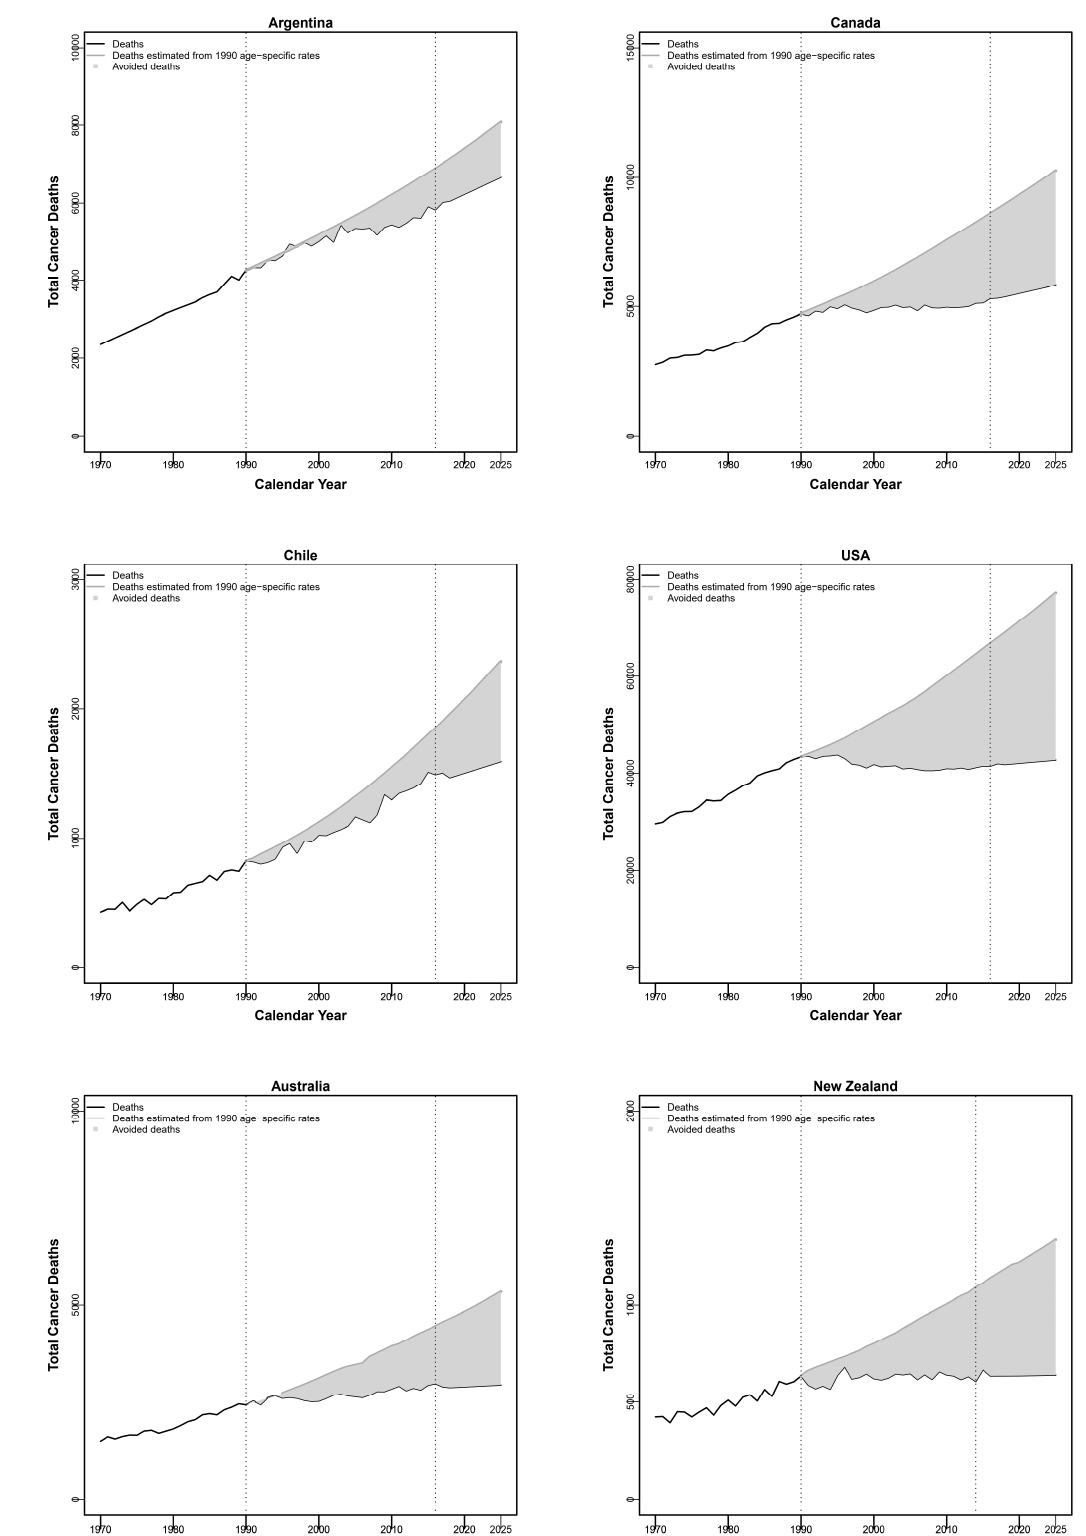
Figure 3. Estimated numbers of avoided breast cancer deaths between 1991 and 2025, assuming constant age-specific rates in 1990 (light grey area).